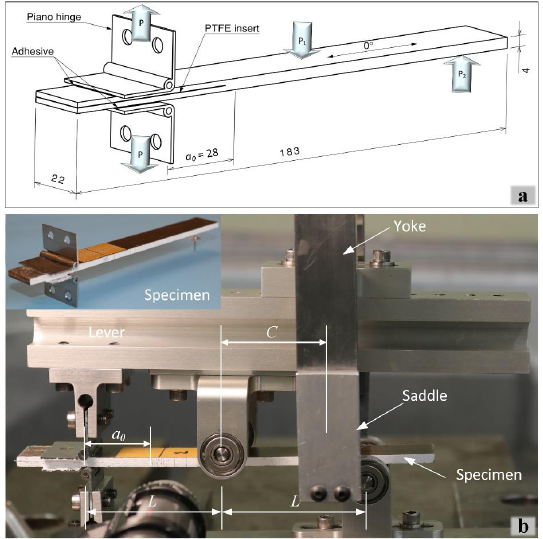
Figure 7. Mixed-Mode Bending (MMB) test specimen for Mixed-mode I/II delamination: ( a ) configuration and dimensions, ( b ) test fixture and final test specimen.